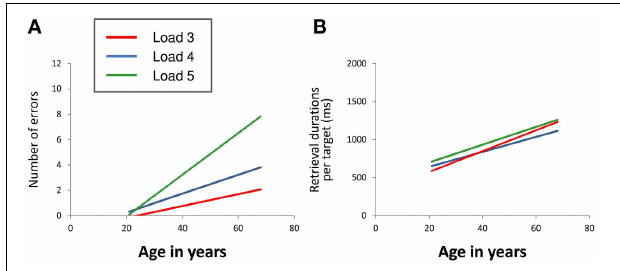
FIGURE 2 | Linear relation between age and mean number of errors (A) and between age and mean retrieval durations per target (B) at CBT load levels 3(redline),4(blueline),and5(greenline).Theregressionlinesshowthatthe number of errors increased with increasing age. At load level 4, there was a sharper increase than at load level 3 with the sharpest increase at load level 5 (load × age interaction). Mean retrieval durations per target also increased with increasing age. The extent of increase did not differ between the different load levels (CBT, Corsi Block-Tapping test; ms, milliseconds).